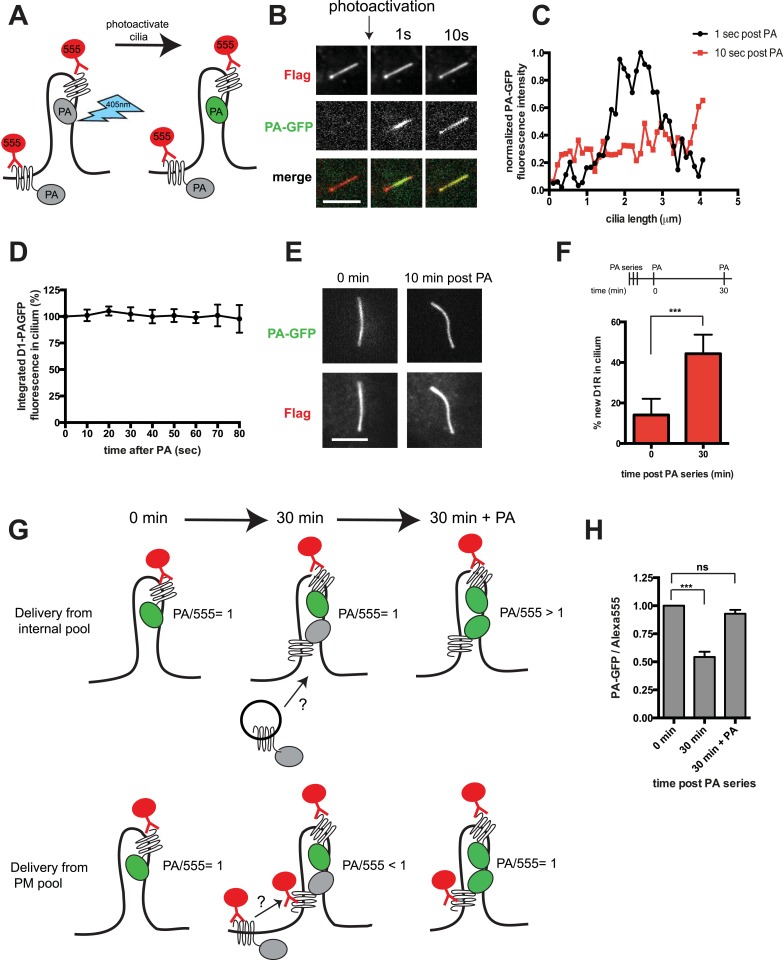
D1Rs are mobile in the ciliary membrane and delivered from the extra-ciliary plasma membrane.(A) Schematic for local labeling of D1-type dopamine receptor (D1R) in a cilium using PA-GFP. IMCD3 cells expressing Flag-D1-PAGFP were labeled with anti-Flag antibody conjugated to Alexa555 to visualize the overall surface receptor pool. A point-focused 405-nm laser spot was used to locally photoactivate receptors on the mid-portion of the cilium. Non-fluorescent PA-GFP is depicted in gray, fluorescent state in green. (B) Live cell confocal images of a representative cilium showing the frame immediately before the photoactivation pulse (left column), and frames acquired 1 s (middle column) and 10 s (right column) after local photoactivation. The Flag-Alexa555 signal labeling the entire surface receptor pool (top row) was present throughout the cilium at all time points. PA-GFP fluorescence representing the photoactivated pool was non-uniformly distributed at 1 s and uniformly distributed along the cilium within 10 s. (C) Line scan analysis of PA-GFP fluorescence along the cilium from the example in panel B. (D) Integrated PA-GFP fluorescence signal in the cilium as a function of time after the 405-nm laser pulse. The PA-GFP fluorescence at time = 0 was set at 100%. Points represent the mean fraction of PA-GFP fluorescence present in the cilium over an 80-s imaging interval. Error bars represent SD from analysis of n = 6 cilia. There was no detectable loss of ciliary PA-GFP signal quantified over an 80-s interval. (E) Confocal images of a representative cilium acquired immediately after (0 min) and 10 min after photoactivation, showing that the locally photoactivated receptor pool was largely retained in the cilium even after this longer interval. (F) Assessing new D1R delivery to the cilium by saturation photoactivation and the sequential ‘image-photoactivate-image’ scheme described in the ‘Materials and methods’. Bars represent mean fractional increase in ciliary PA-GFP fluorescence elicited by the subsequent test pulse. Error bars represent SD for n = 7 cilia. (G) Schematic for modifying the saturation photoactivation method to assess source of newly delivered D1Rs, based on the ratio of integrated PA-GFP/Alexa555 fluorescence (PA/555) measured in the cilium as a function of time. The initial condition is depicted on the left (‘0 min’) with the fluorescence ratio (PA/555) arbitrarily set to 1. If new receptors enter the cilium from an internal membrane pool during the 30-min incubation period (depicted in center, ‘30 min’), they contribute neither Alexa555 nor PA-GFP signal, so the fluorescence ratio is unchanged from the initial condition (PA/555 = 1). After the subsequent 405-nm test pulse (depicted at right, ‘30 min + PA’), the PA-GFP signal increases without any change in Alexa555 signal, elevating the fluorescence ratio above the initial condition (PA/555 > 1). If new receptors enter the cilium from the extra-ciliary plasma membrane pool, they contribute Alexa555 but not PA-GFP signal during the 30-min incubation, reducing the fluorescence ratio from the initial condition (PA/555 < 1). The subsequent 405-nm pulse restores the fluorescence ratio to the initial value (PA/555 = 1). (H) Experimental results from the strategy depicted in panel G. Bars represent the mean ratio of integrated PA-GFP/Alexa555 fluorescence measured in the cilium. Error bars represent SD from n = 6 cilia. (***) p < 0.001. Scale bars, 5 μm.